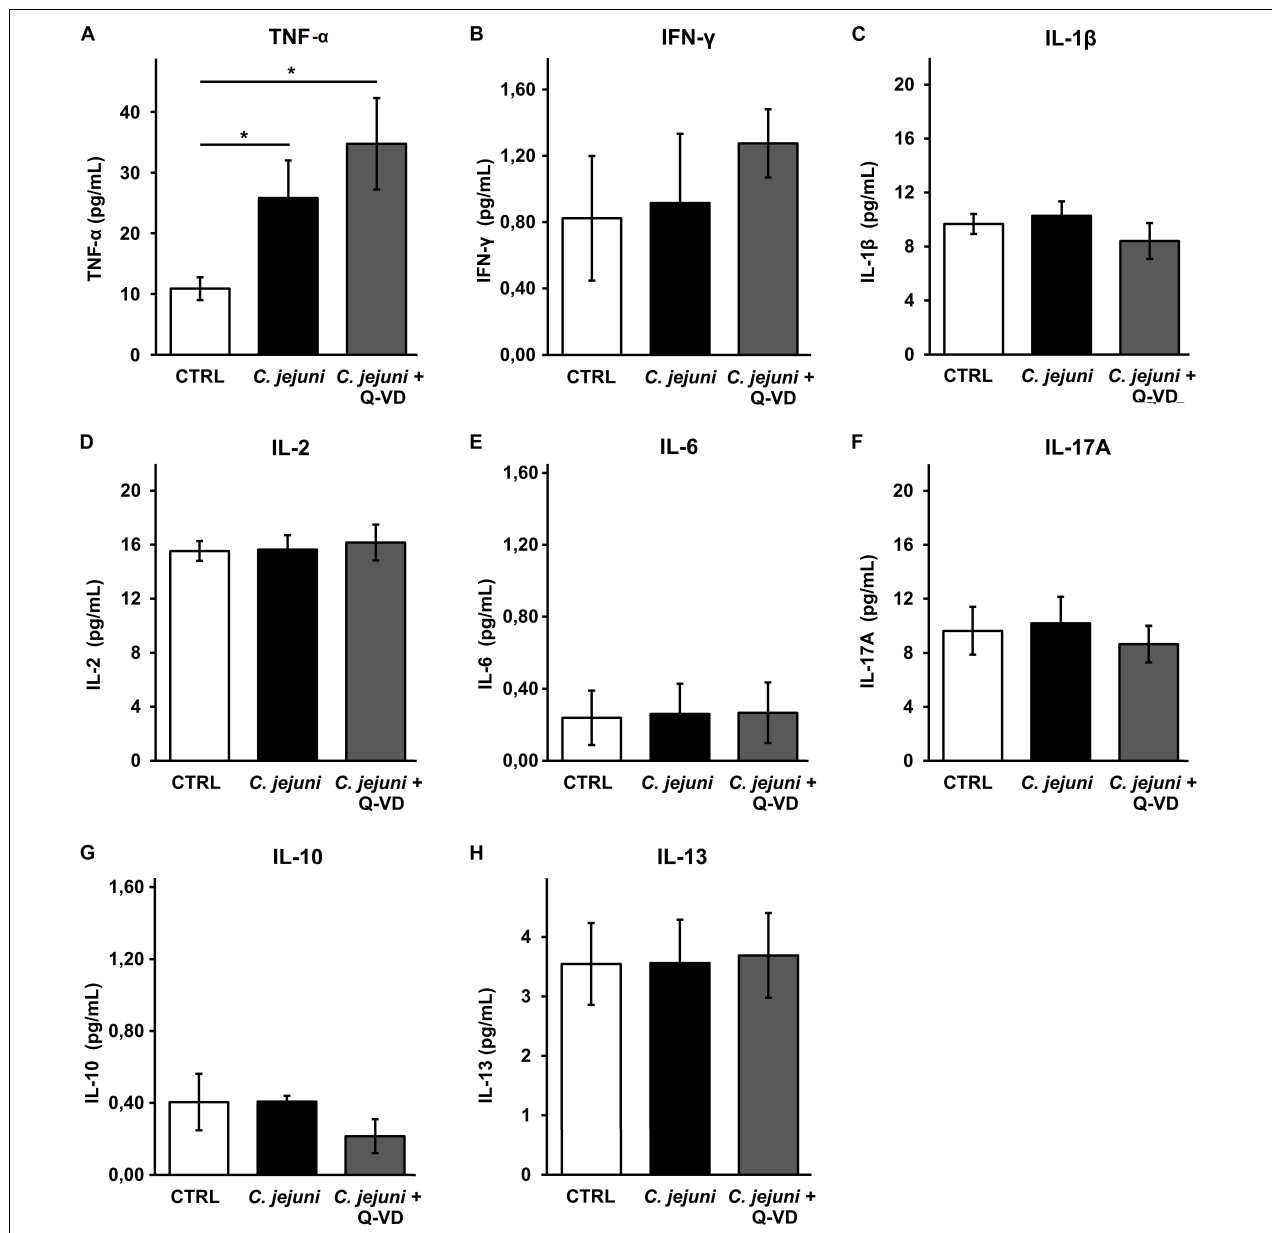
FIGURE 6 | Immune activation during C. jejuni infection. Co-cultures of HT-29/B6-GR/MR and THP-1 cells were infected with C. jejuni with or without apoptosis inhibitor Q-VD-OPh. The secretion of the barrier relevant cytokines such as TNF- α , INF- γ , and IL-1 β (A–C) as well as further interleukins (D–H) were assessed in the infected co-culture after 22 h. Cytokine concentration was measured in the culture medium from basal compartment. The concentrations are presented as mean values ± SEM, n = 6, * p < 0.05, unpaired Student’s t -test with Bonferroni-Holm adjustment for multiple